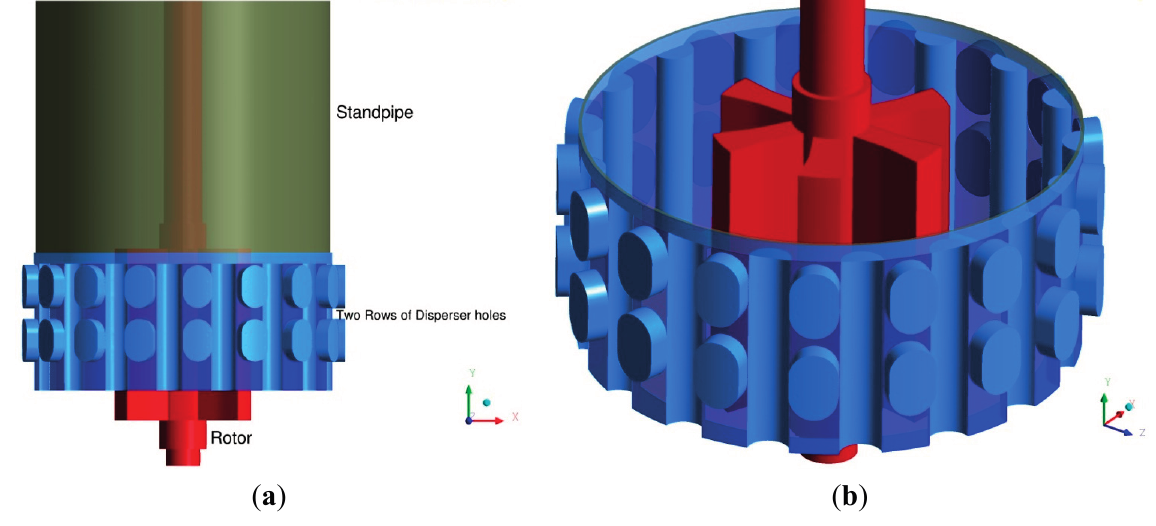
Figure 2. Details of Wemco-0.8m 3 rotor, disperser, and standpipe; ( a ) relative vertical position of rotor and disperse; ( b ) rotor and